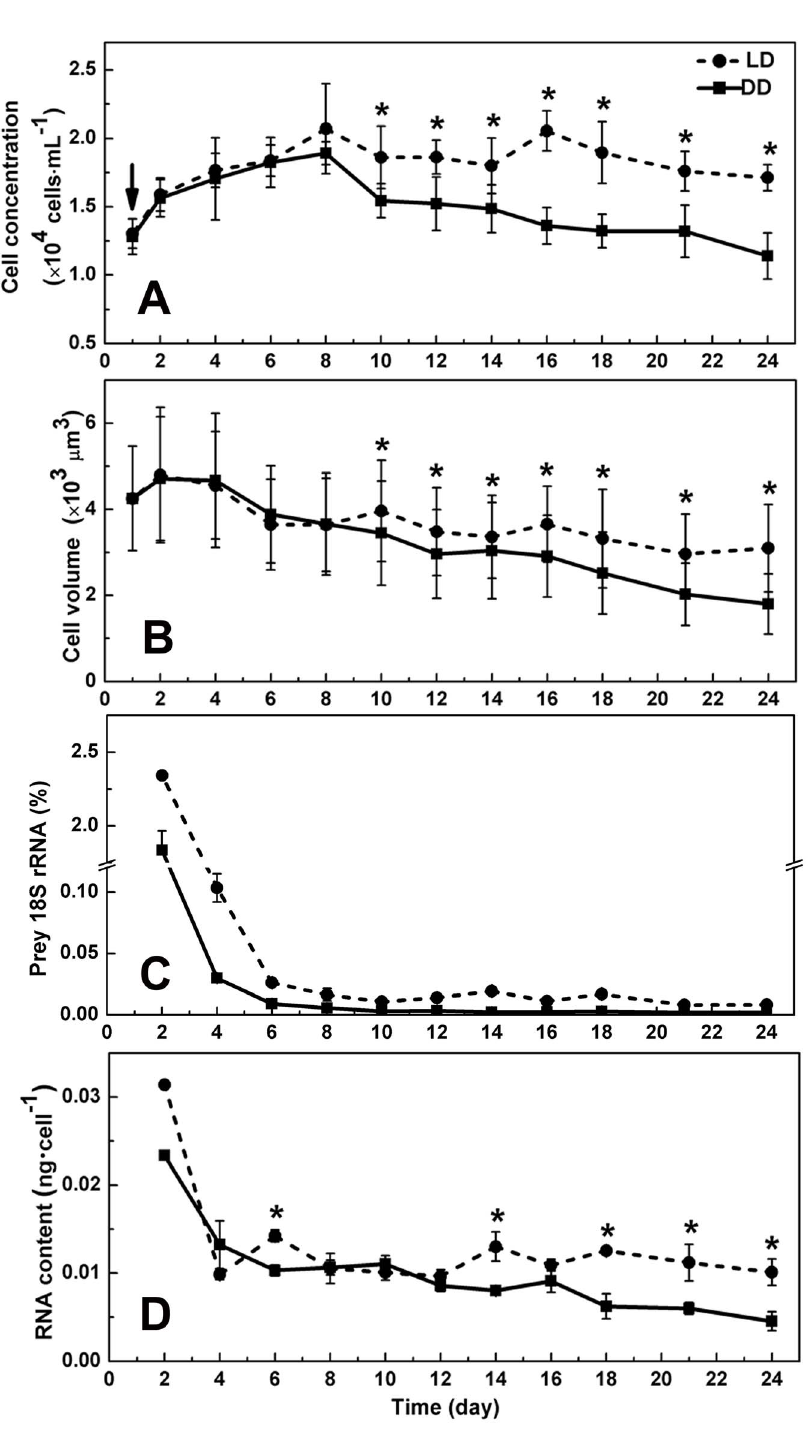
Fig. 2. Growth curve (A), cell volume (B), prey 18S rRNA percentage (C), cellular total RNA content (D) of starved O . marina . RT-qPCR was carried out to quantify the 18S rRNA level of both O . marina and D . tertiolecta in the cDNA libraries from both conditions. Y-axis in (C) indicates the ratio of prey 18S rRNA and O . marina 18S rRNA. LD, cultures grown under light: dark cycle; DD, cultures grown under continuous darkness; error bars, standard deviation. Significant differences between LD and DD groups were marked with ‘‘*’’. Arrow in the figure denotes time when food was